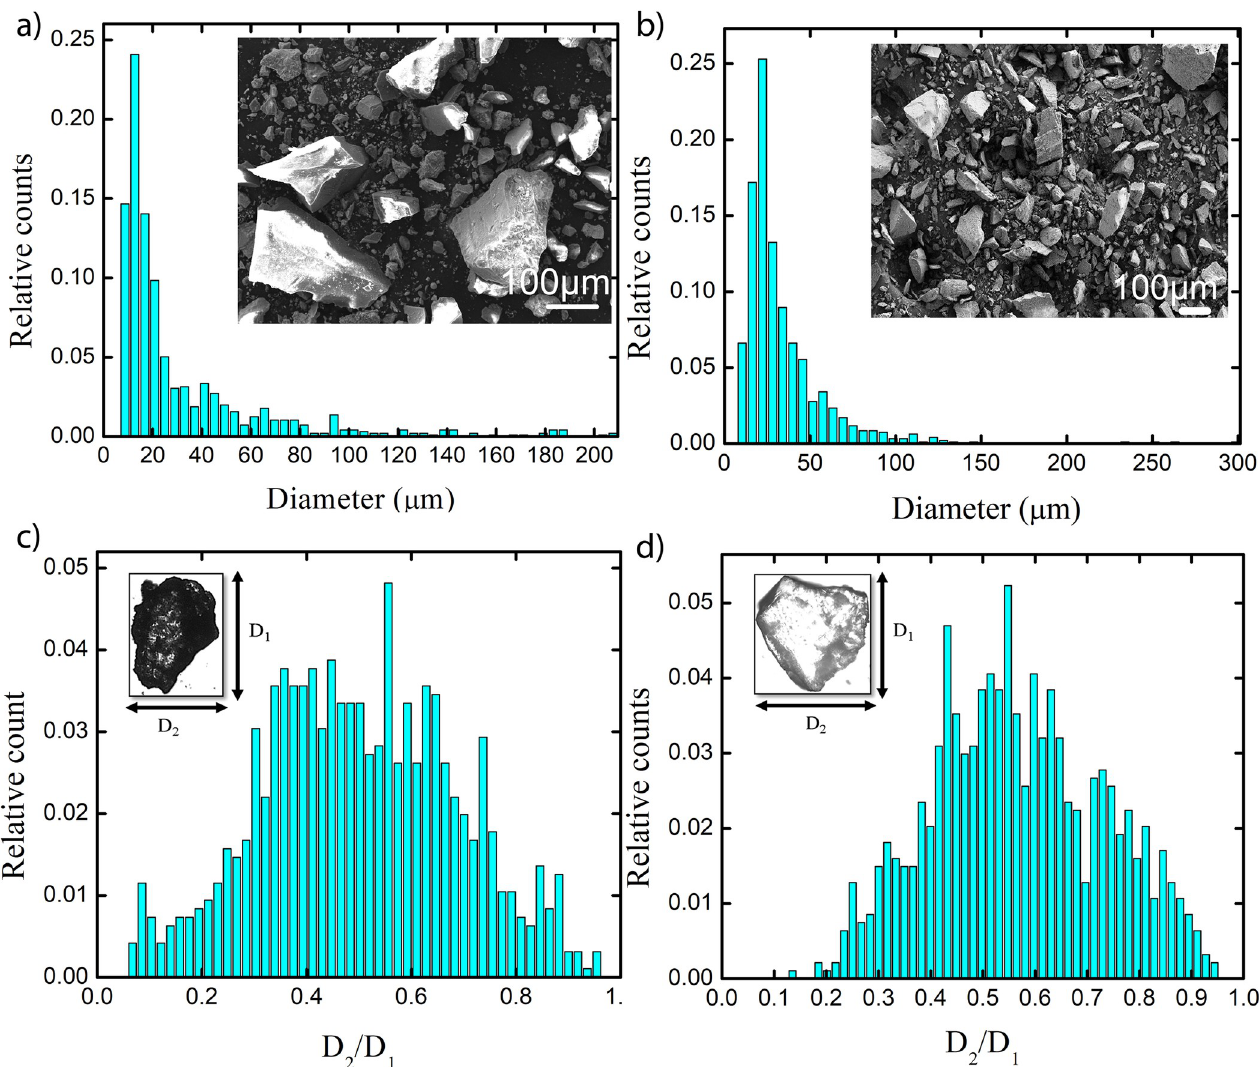
Fig 3. Characterization of raw MSS and LSS: Size distribution of a) MSS particles with an inset FESEM image of MSS and b). LSS particles with an inset FESEM image of LSS c) Aspect ratio for MSS particles and d) Aspect ratio for LSS particles.